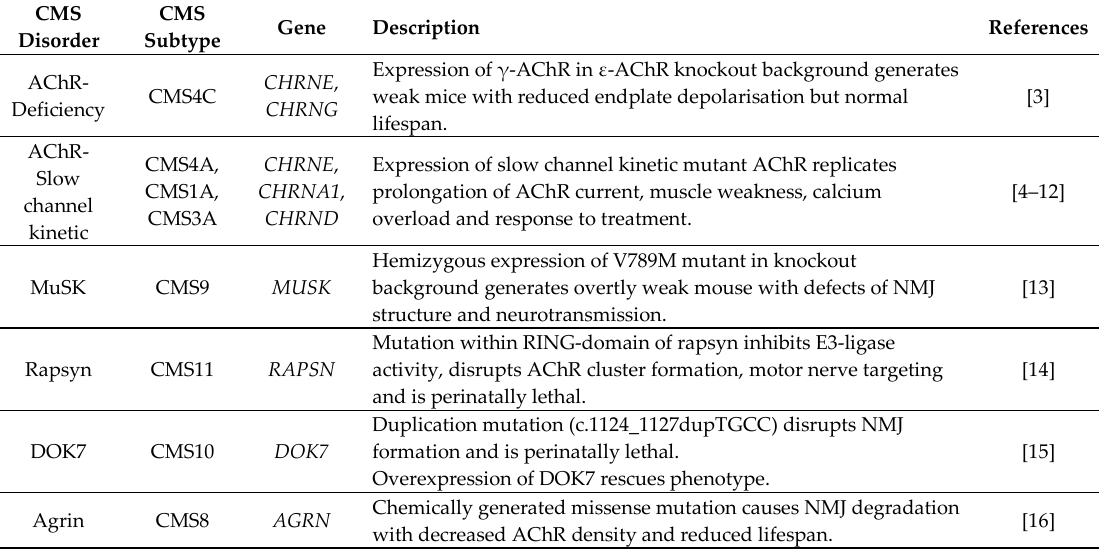
Table 1. Summary of specific CMS-related mutant animal models that replicate aspects of disease